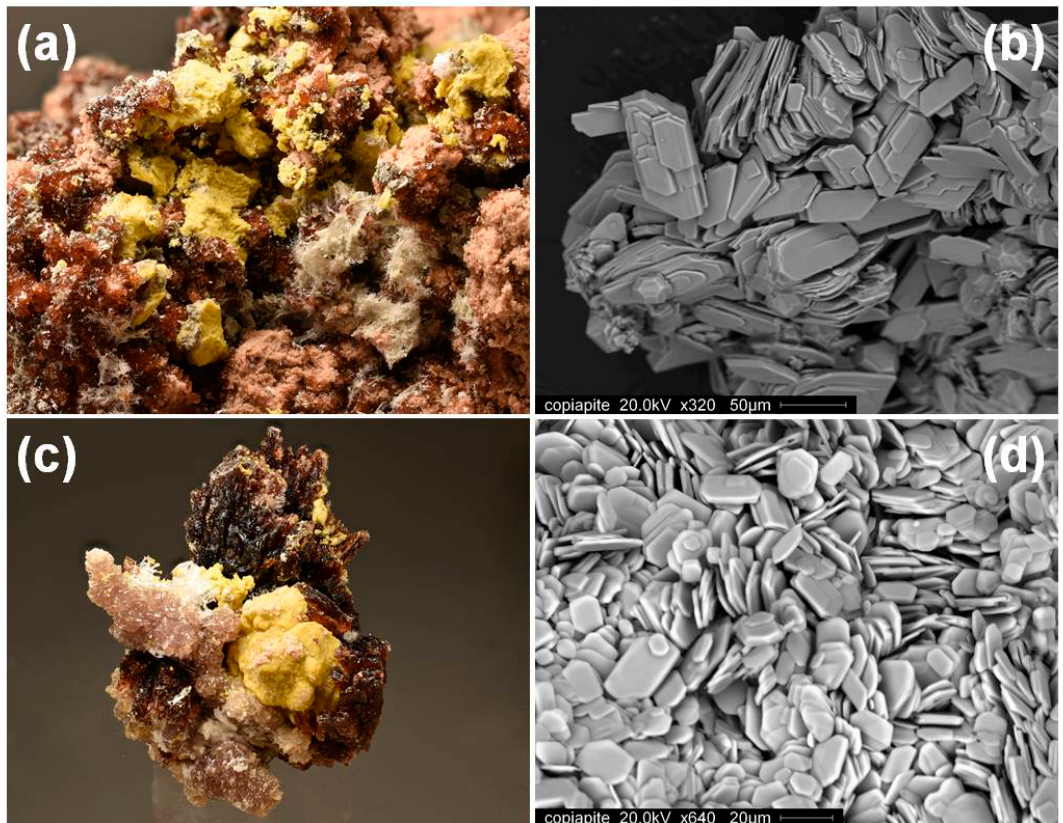
Figure 6. Copiapite group minerals from the pyrite ores of the Apuan Alps. ( a ) Magnesiocopiapite, as microcrystalline canary-yellow masses up to 5 mm across, with brown römerite and hairy halotrichite from the Fornovolasco mine. ( b ) Details of the crystal morphology of magnesiocopiapite from the previous locality. ( c ) Magnesiocopiapite, as rounded aggregates of canary-yellow microcrystals, up to 1 cm across, associated with krausite, halotrichite, and römerite, from the Monte Arsiccio mine. ( d ) A copiapite group mineral from the Pollone mine, as micrometer-sized tabular crystals.